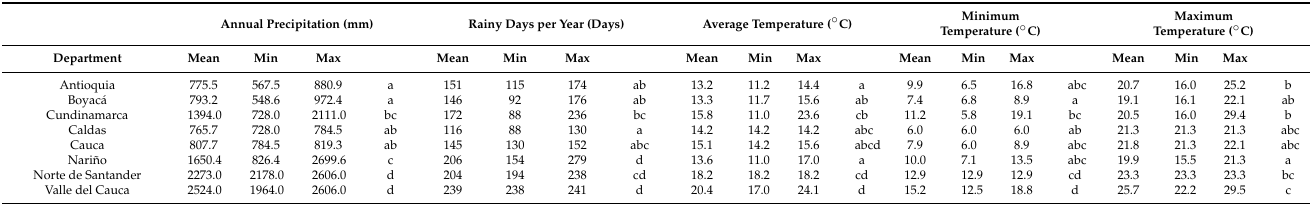
Table 4. Climatic data for the Colombian departments included in this study. The table presents historical normalized data from 1982 to 2010 [50], including annual precipitation, number of rainy days per year, and average, minimum and maximum temperatures. Data were obtained from the closest weather station to the sampled points in eight departments of